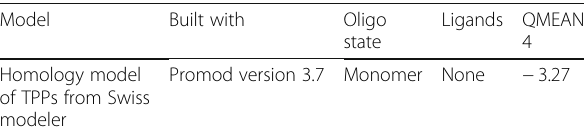
Table 4 Representative homology model in comparison to